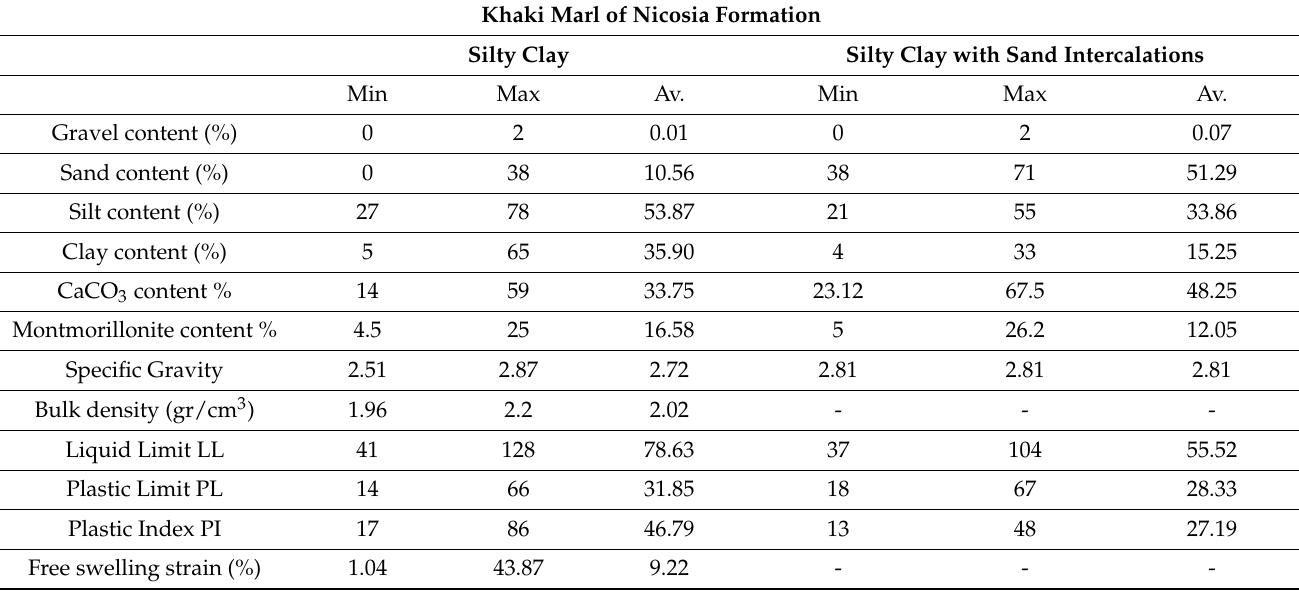
Table 1. Physical and mechanical parameters of the khaki